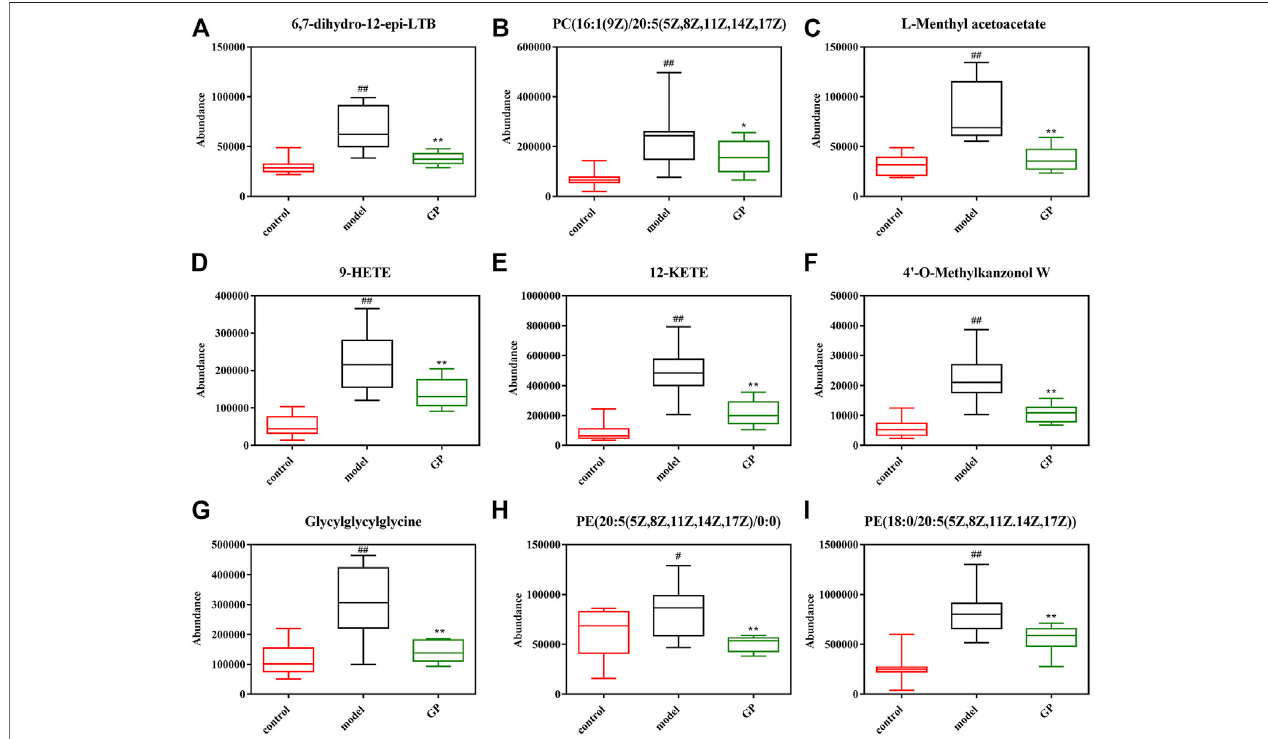
FIGURE7| Relativelevelsoftheselected37metabolitesintheplasmaofmicefromthecontrol,model,andGPgroups. Dataareexpressed asthemean ± SD. “ # ” represents control group vs. model group (# p < 0.05, ## p < 0.01); “ * ” represents GP group vs. the model group (* p < 0.05, ** p < 0.01).